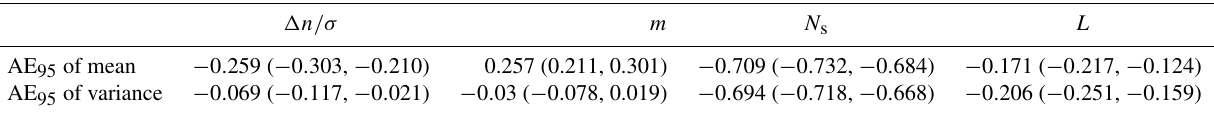
Figure 1. Visualization of LiSBOA applied to a Monte Carlo simulation of the synthetic field in Eq. (9) for the case with N s = 20000, L = 200, (cid:49)n/σ = 4, and m = 5. (a) Samples, (b) 3D reconstructed mean field, g m , and (c) 3D reconstructed variance, v m . Table 1. Pearson correlation coefficient between the AE 95 of the mean and variance and the parameters (cid:49)n/σ , m , N s , and L . The values in parenthesis represent the 95% confidence